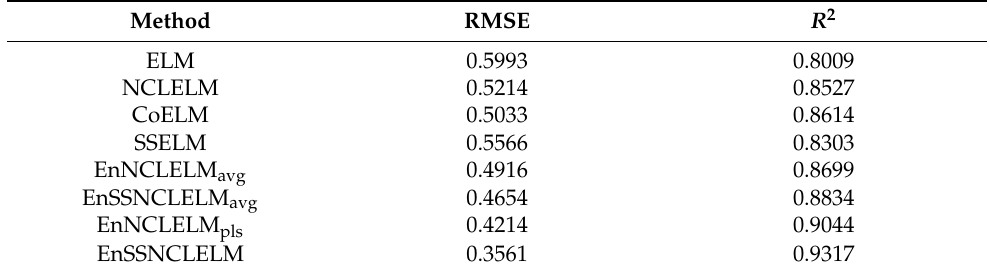
Table 4. Prediction results of the various soft sensor methods for the CTC fermentation process. Method